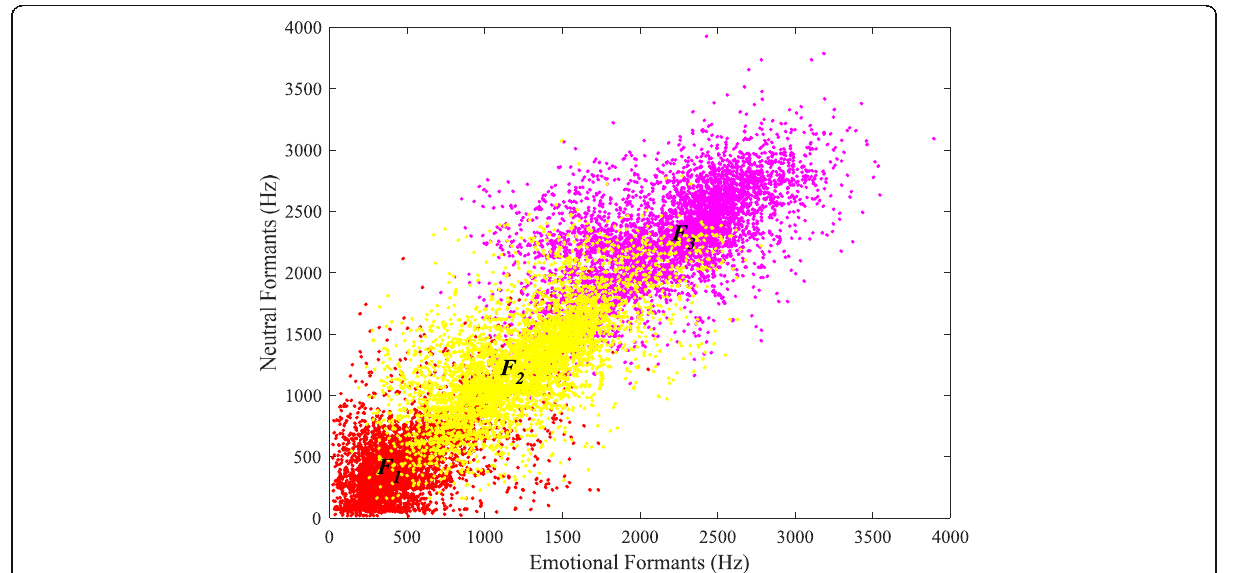
Fig. 3 The distribution of formant frequencies, F 1 , F 2 , and F 3 , for Disgust obtained from all utterances of the male speaker in the Persian ESD database